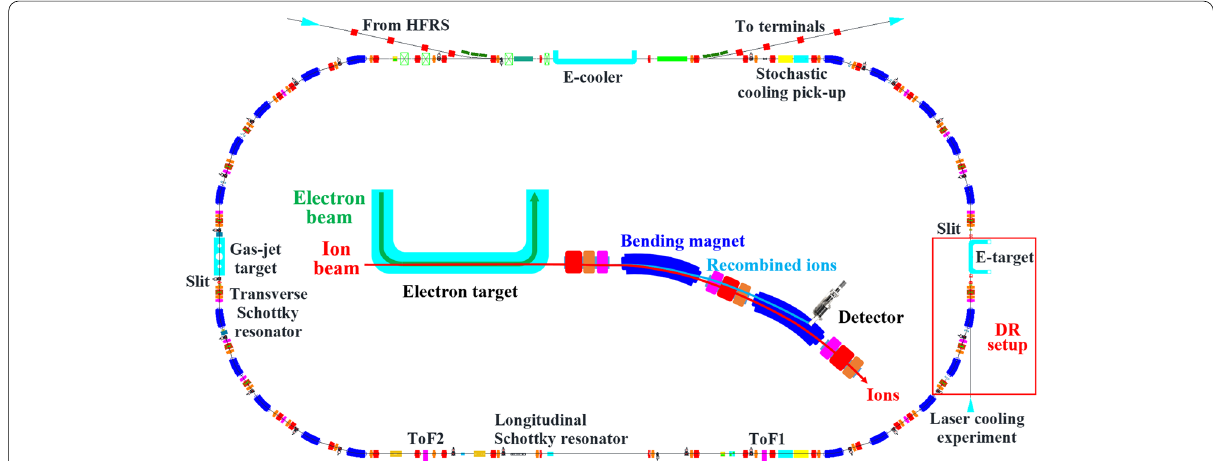
Fig. 11 A sketch of the dielectronic recombination spectrometer at the spectrometer ring. The DR experimental region is indicated with the red box, which is enlarged and inserted in the middle of the figure. The components of a stochastic cooling device are indicated, including the stochastic cooling kicker, the longitudinal Schottky resonator, and the transverse Schottky resonator. E-cooler and E-target stand for the electron cooler and electron target, respectively. The isochronous mass spectrometer is built using the time-of-flight detectors ToF1 and ToF2, and the setup for in-ring nuclear reactions is built at the gas-jet